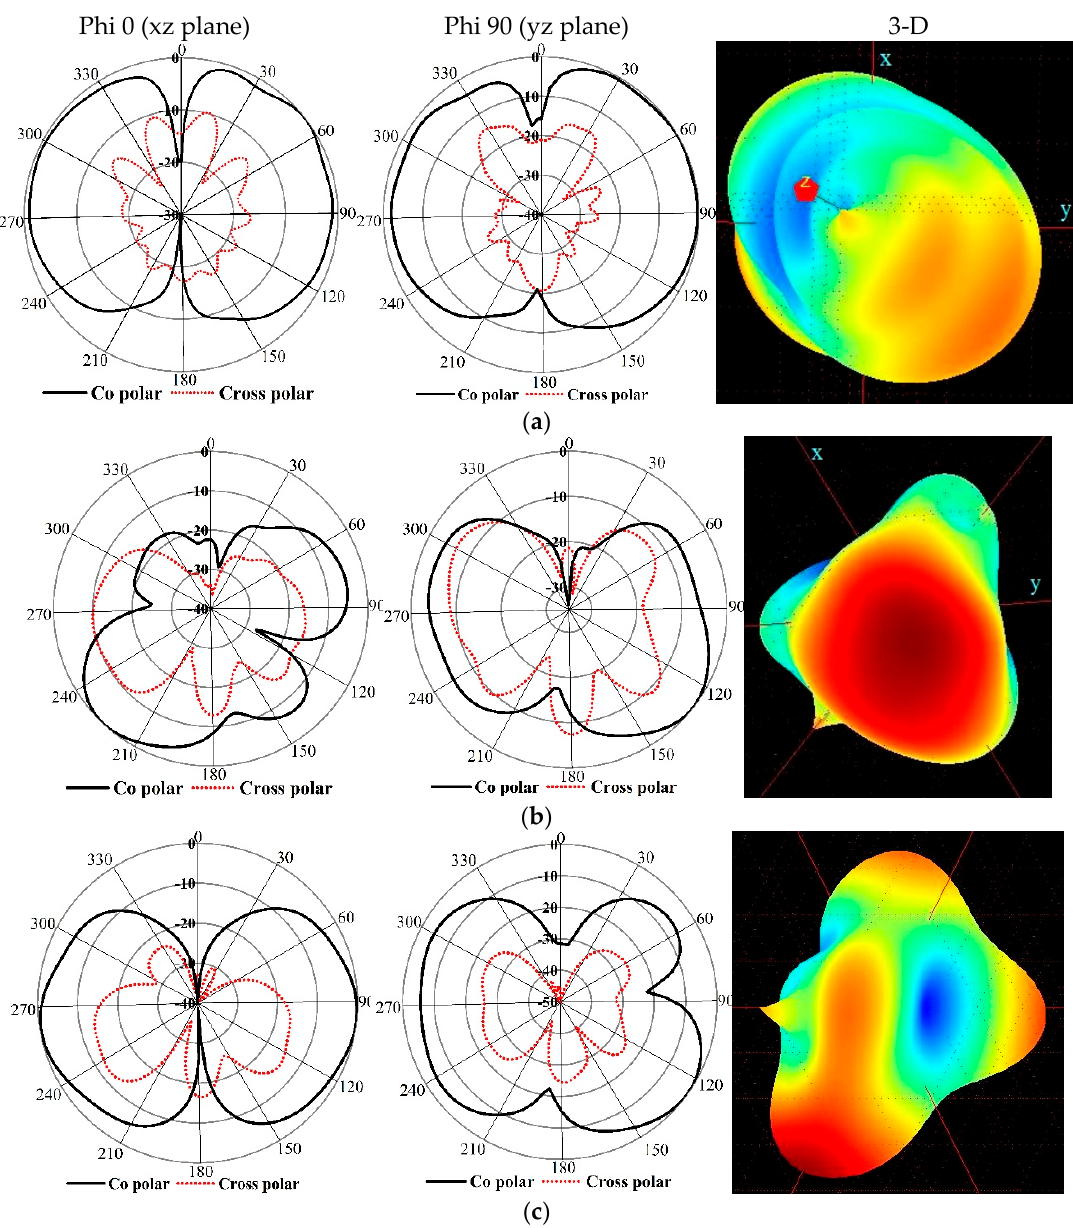
Figure 9. Measured radiation pattern of cross ‐ polarization and co ‐ polarization of the proposed antenna at ( a ) 4.01 GHz ( b ) 7.63 GHz ( c ) 8.71 GHz.